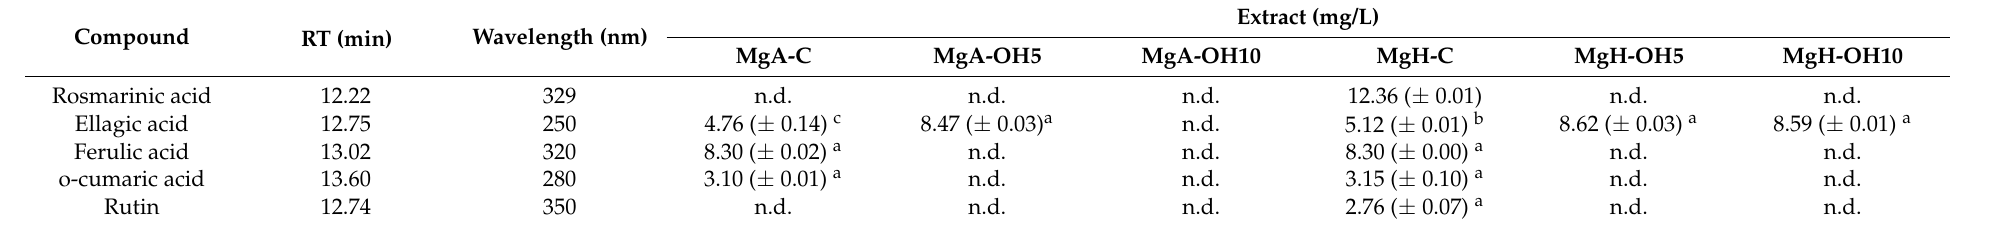
Table 4. Phenolic profile obtained by UHPLC of the different extracts of M. geometrizans (Mg)